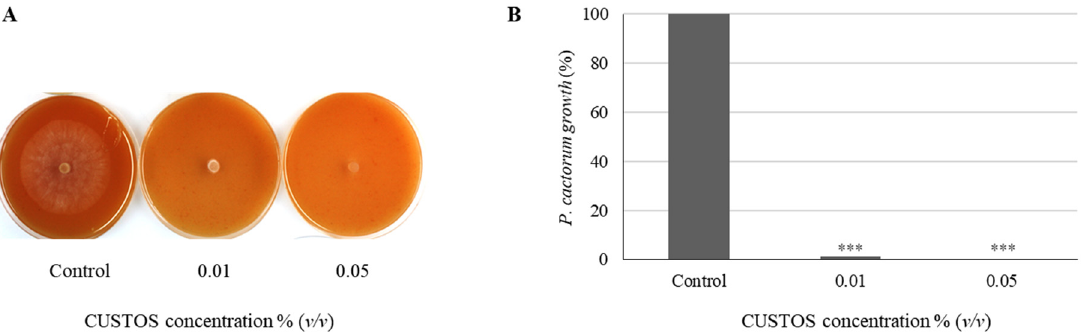
Figure 1. Inhibition by CUSTOS of fungal growth under the lab condition. After 5 dpi, the concentration at 0.05% completely inhibited the growth of Phytophthora cactorum . The concentration at 0.01% allowed minimal pathogen growth ( A , B ). Bars represent the standard deviation of three replicates and significant changes are marked: *** p < 0.001 (Student’s t -test).